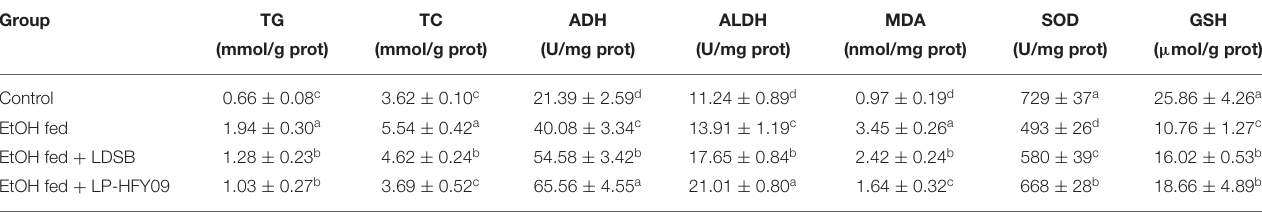
TABLE 3 | Liver levels of triglyceride (TG), total cholesterol (TC), alcohol dehydrogenase (ADH), acetaldehyde dehydrogenase (ALDH), superoxide dismutase (SOD), and glutathione (GSH) in hepatic tissue of mice ( n = 10).